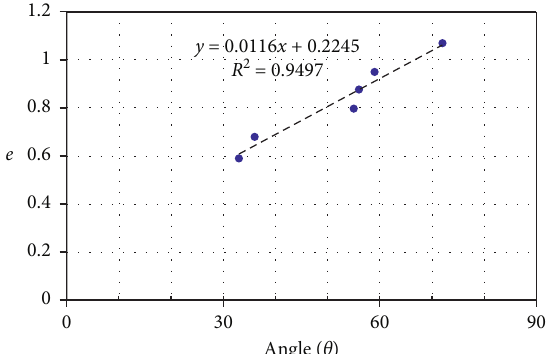
Figure 12: The rotation angle of a gastropod skeleton fragment from applied simple shear direction during one-dimensional static